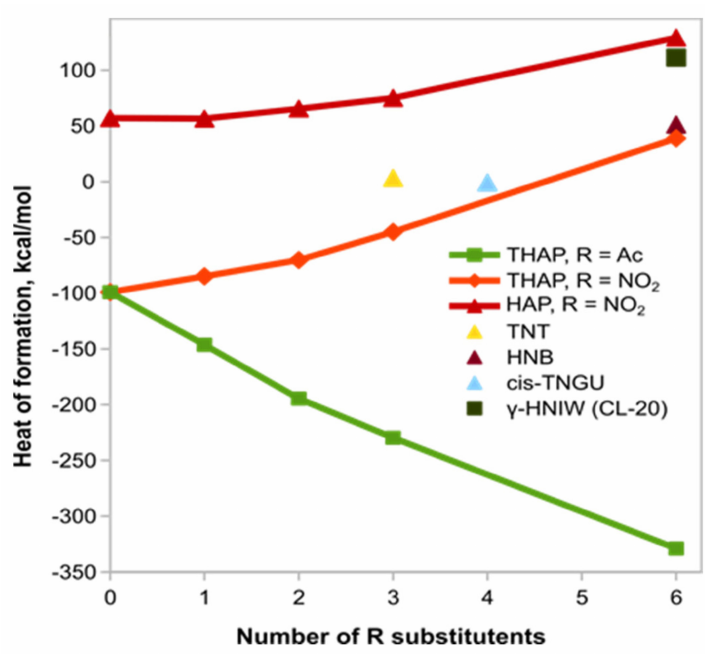
Figure 6. Heats of formation plotted against the number of substituents.